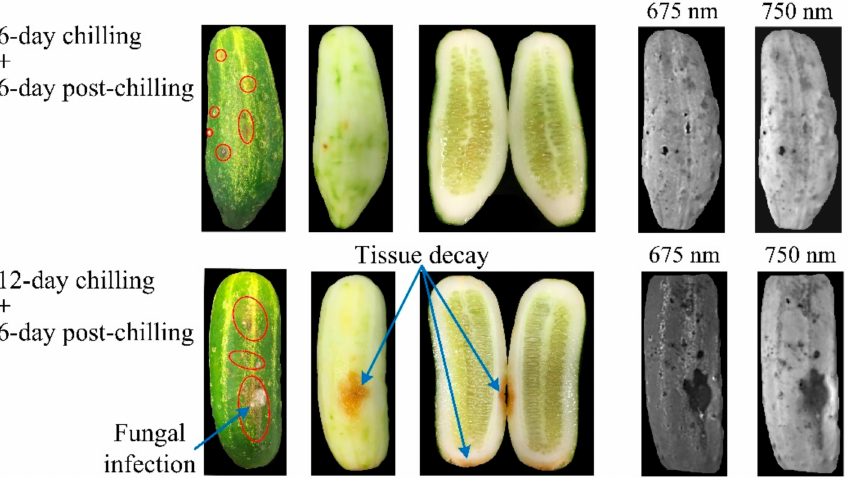
Figure 7. Color photos and chlorophyll fluorescence images for two chilling-injured pickling cu- cumbers (one sample in each row). The areas enclosed by the red ellipses indicate the noticeable tissue